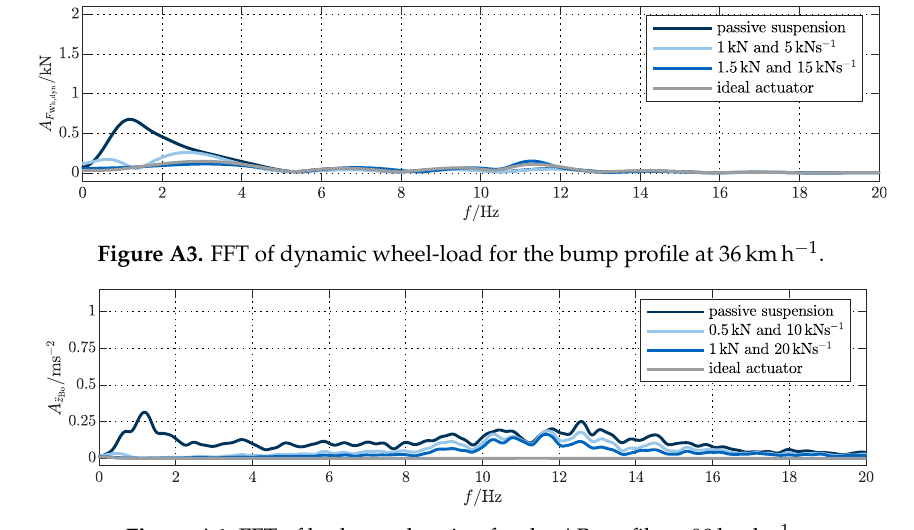
Figure A4. FFT of body acceleration for the AB profile at 90kmh − 1 .